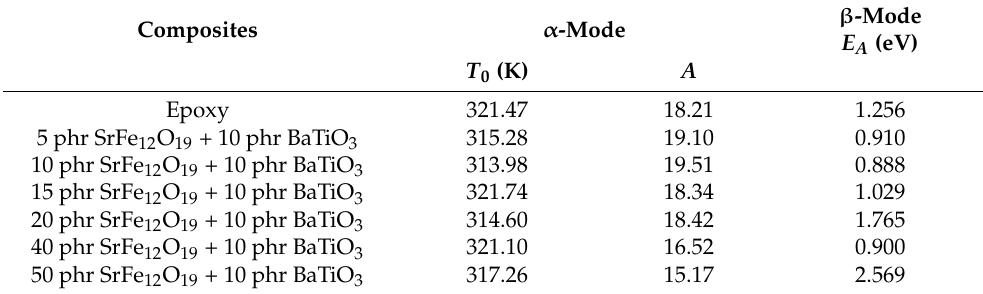
Table 1. Parameters evaluated via fitting data with Equations (3) and (4) for α - and β -process. Composites α